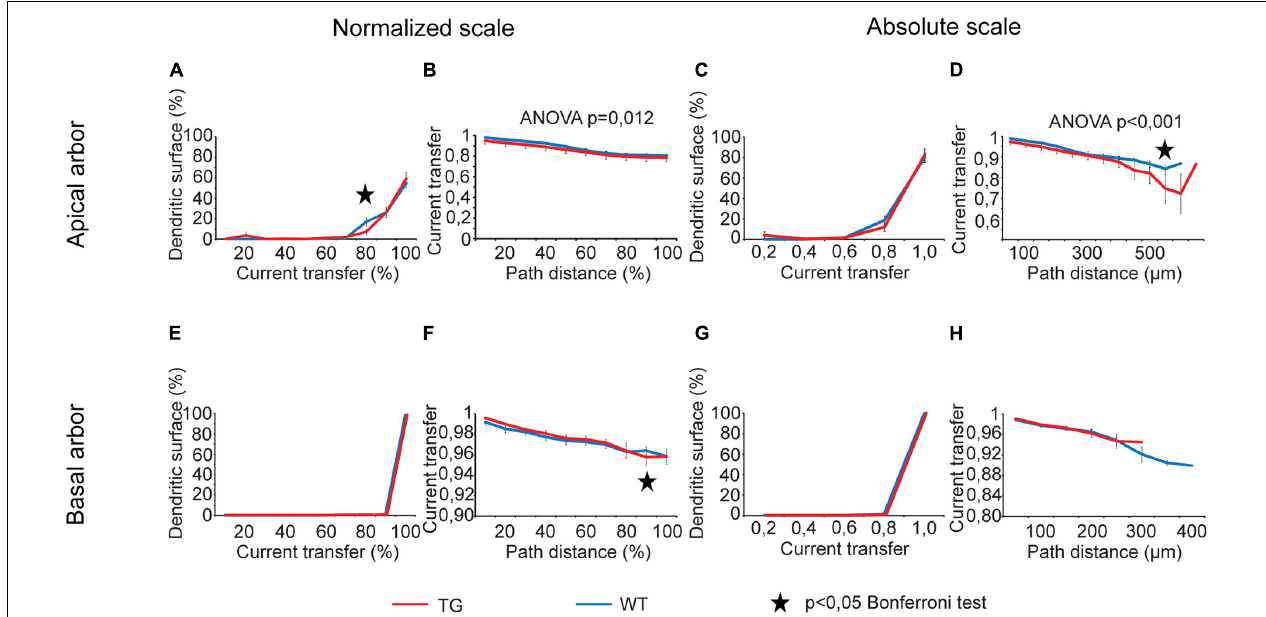
FIGURE 5 | Alterations in current transfers of locally generated PSPs in advanced tauopathy. Comparison graphs showing alterations in dendritic impulse propagation of TG (red lines) neurons relative to control, WT neurons (blue lines). Two types of comparison graphs are presented: one of them shows percentages of dendritic surface area (an approximation of the fraction of dendritic synapses) with similar transfers of locally generated PSPs (A,C,E,G) ; the other one displays location dependence of the current transfer (B,D,F,H) . Comparison graphs were computed both along absolute (right half) and normalized scales (left half), where path distances and transfers were measured as percentages of their maximum values. Apical (upper panels) and basal (lower panels) dendritic arbors were analyzed separately. Overall statistical evaluations of comparison graphs were made by two-way ANOVA tests. Significance levels of these ANOVA tests were indicated where statistically significant overall alteration in comparison graphs was found (elsewhere p > 0.05). Asterisks mark path distance regions and transfer intervals with statistically significant differences between WT and TG neurons (Bonferroni post hoc test, p < 0.05). Distance regions and transfer intervals with less than 3–3 data points in TG-WT comparisons were omitted from statistical